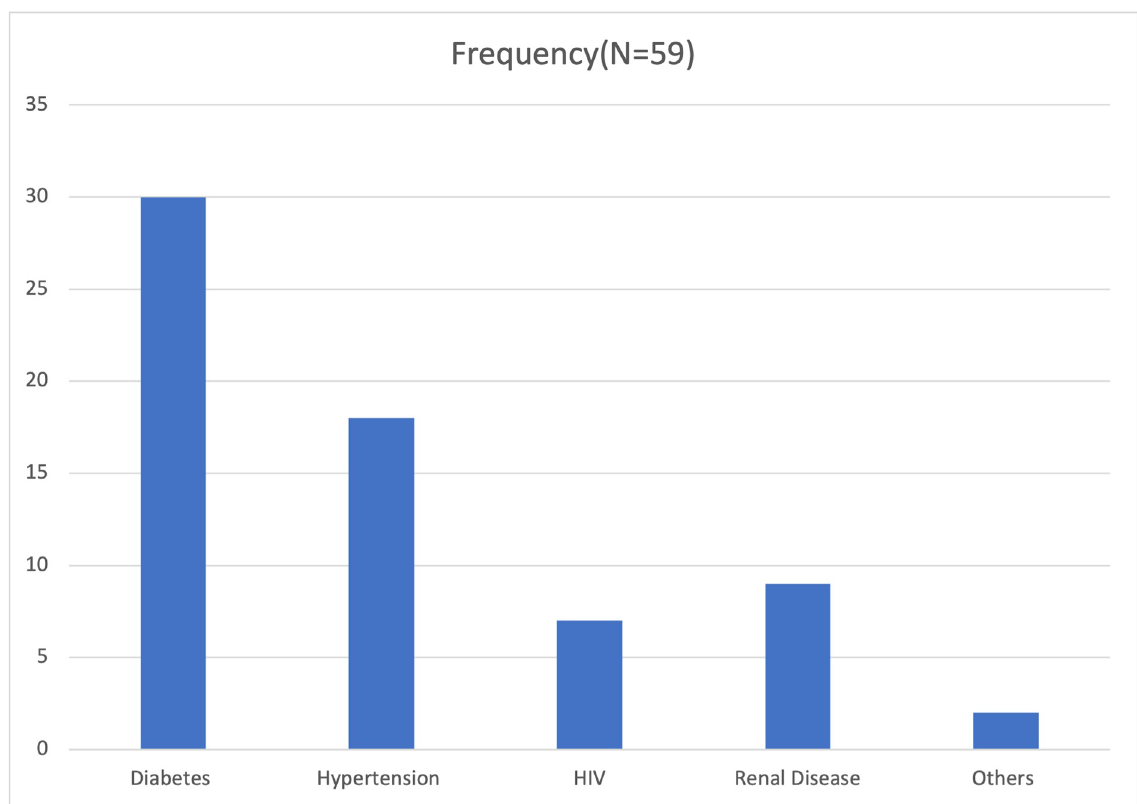
Fig 1. Frequency of comorbidities in study